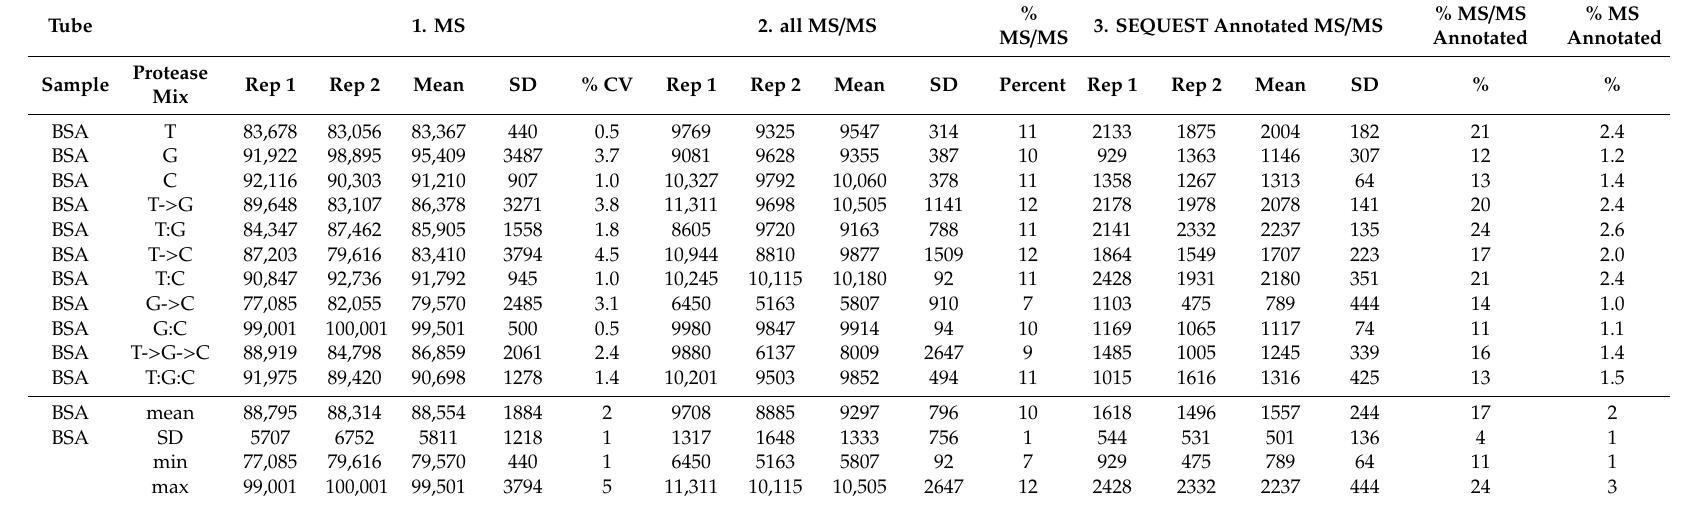
Table 1. Number of MS peaks, MS / MS spectra and MS / MS spectra annotated with SEQUEST for each of the bovine serum albumin (BSA) digests. For protease legend, refer to Figure 1. An arrow (- > ) indicates the order in which the proteases were added. A colon (:) indicates that individual digests were pooled with